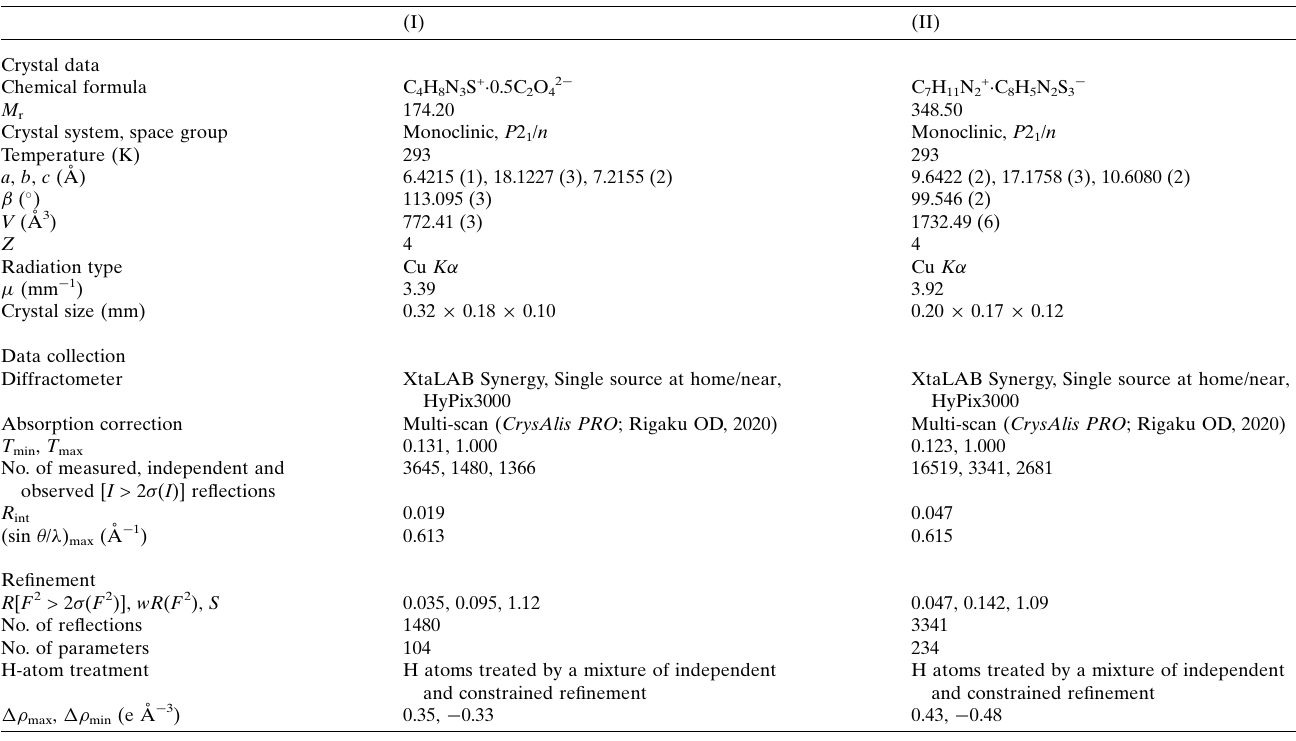
Computer programs: CrysAlis PRO (Rigaku OD, 2020), SHELXT2018/2 (Sheldrick, 2015 a ), SHELXL2018/3 (Sheldrick, 2015 b ), XP (Siemens, 1994), Mercury (Macrae et al. , 2020) and publCIF (Westrip,